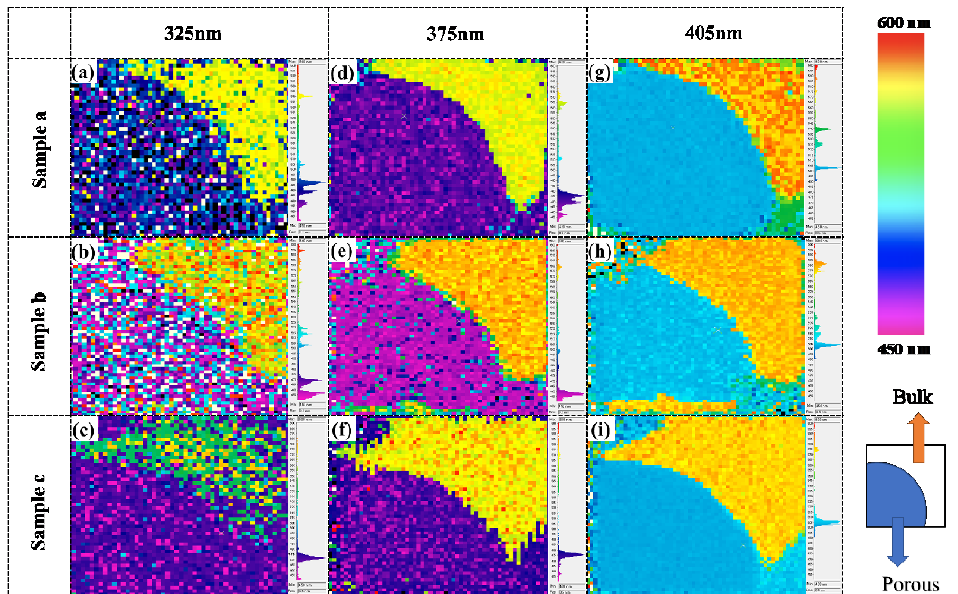
Figure 5. PL mapping of the porous fluorescent SiC samples a, b, and c, before passivation and under excitation, by ( a – c ) the 325 nm laser, ( d – f ) the 375 nm laser, and ( g – i ) the 405 nm laser, respectively. The color bar and configuration of the porous samples (5 × 5 mm 2 ) are illustrated on the right.